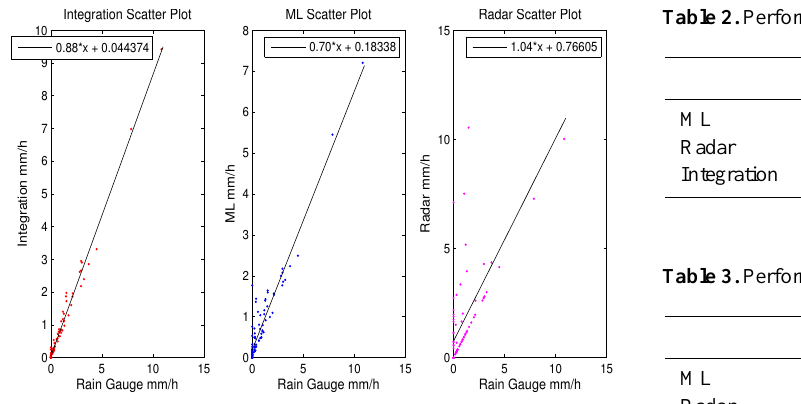
Fig. 15. Rain rates scatter plots of the Integration (left), the ML (middle) and the radar (right) with respect to theraingaugeinDorotsiteforevent(2).